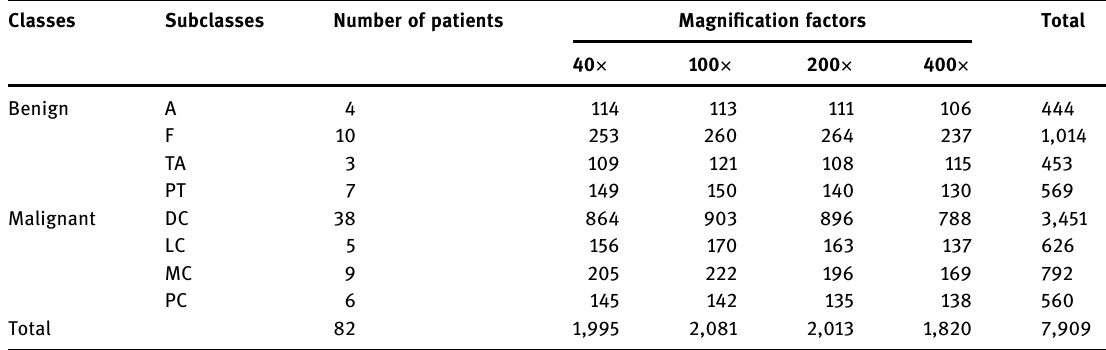
Table 7: Breast cancer datasets